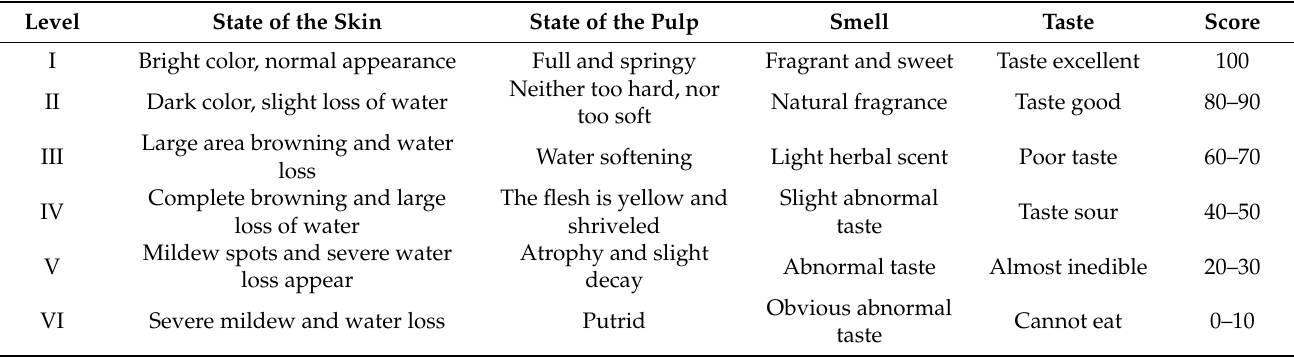
Table 2. Sensory evaluation standard of